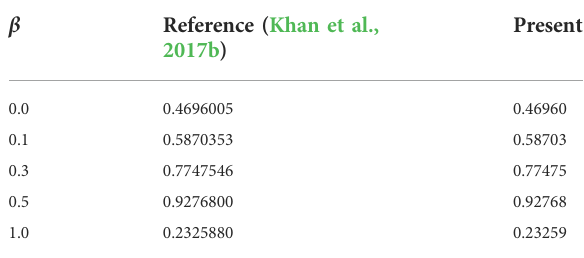
TABLE 1 Comparison values of − f 99 ( 0 ) for different values of β when (cid:2) K (cid:2) M (cid:2) K 1 2